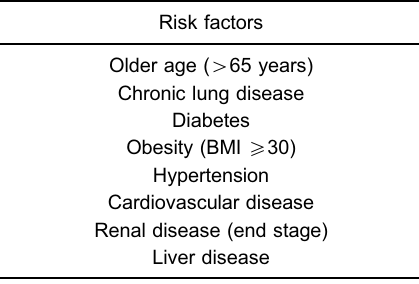
Table 3. Risk factors for severe disease and death in COVID-19.